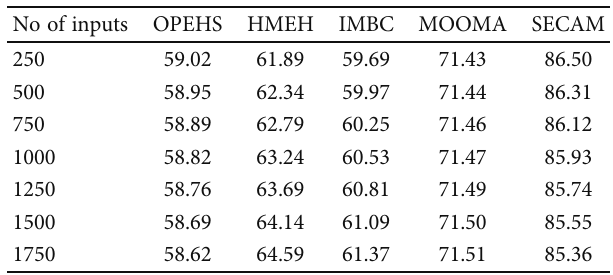
Table 1: Comparison of remote monitoring. Table 2: Comparison of quantitative